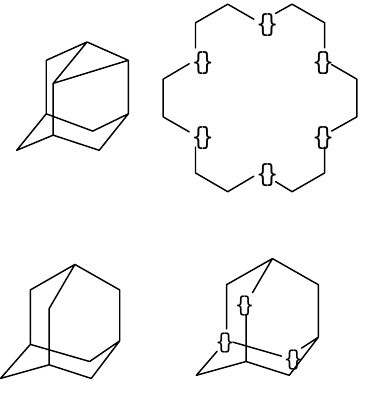
Figure 2. Several examples of fragments used in the database of poly(cyclic)